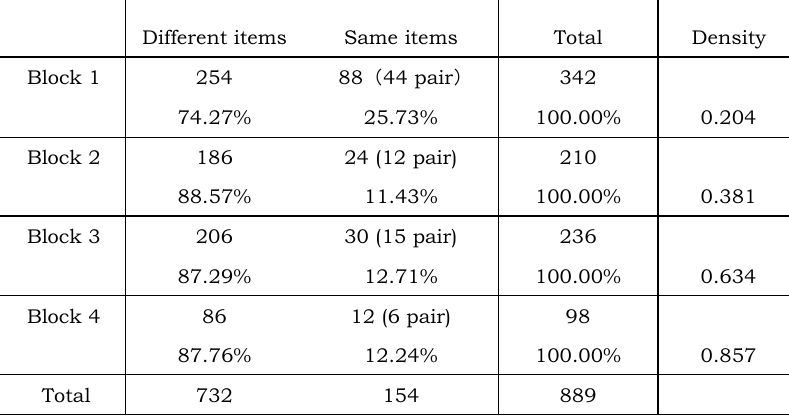
Table 2. Item possession (structural